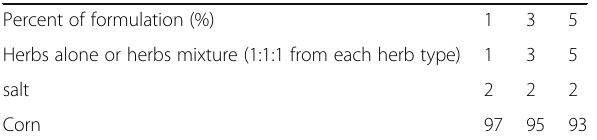
Table 1 Percent % (w/w) of raw blends